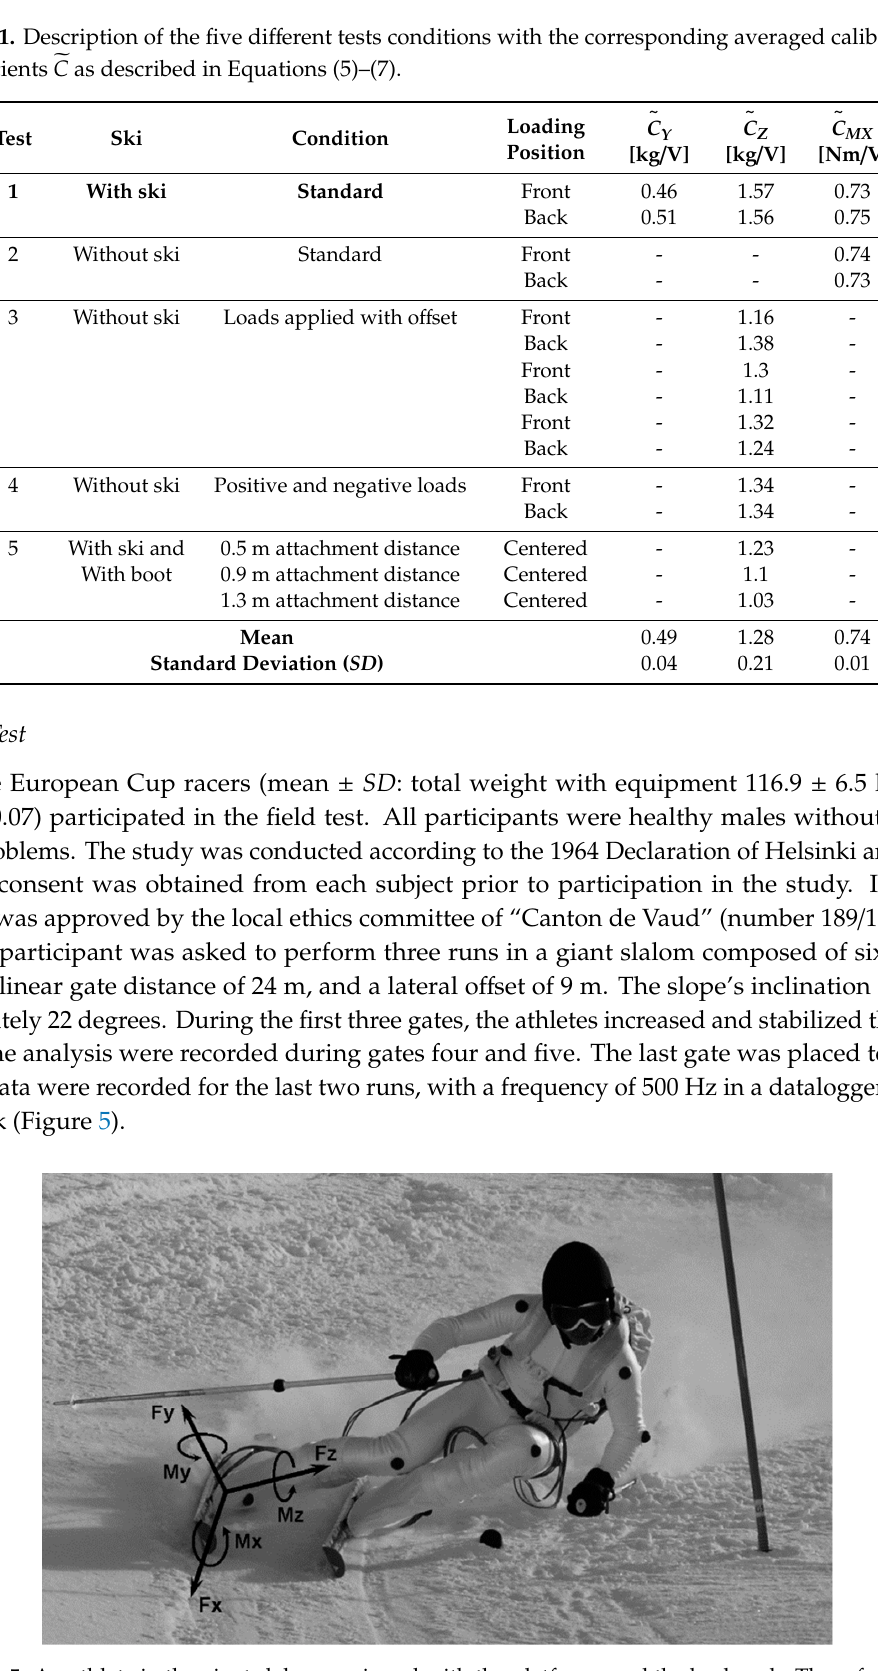
Figure 5. An athlete in the giant slalom equipped with the platforms and the backpack. The referential of the right force platform is also represented. The raw data obtained were filtered using a moving average on a five points window. For each axis of measure and each participant, the mean and standard deviation were calculated. Participant’s averages during a turn cycle were proposed in [N/kg] to allow for a comparison of athletes of different weights. The 95% limit of agreement (±1.96 SD ) was also plotted to show the disparity between athletes. The evolution of the load distribution between the outside and the inside skis was also represented for a turn cycle. 3. Results 3.1. Calibration